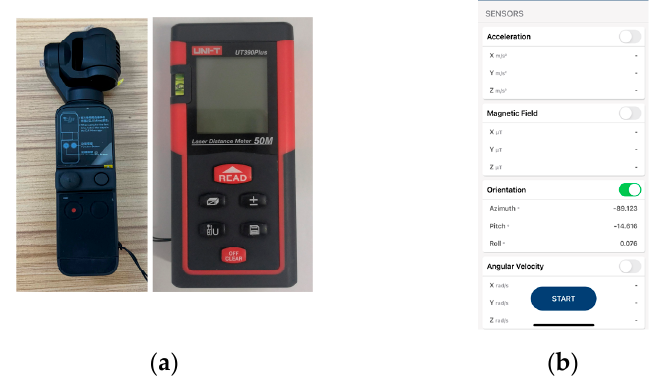
Figure 2. ( a ) DJI Pocket2 and laser rangefinder; ( b ) MATLAB Mobile.